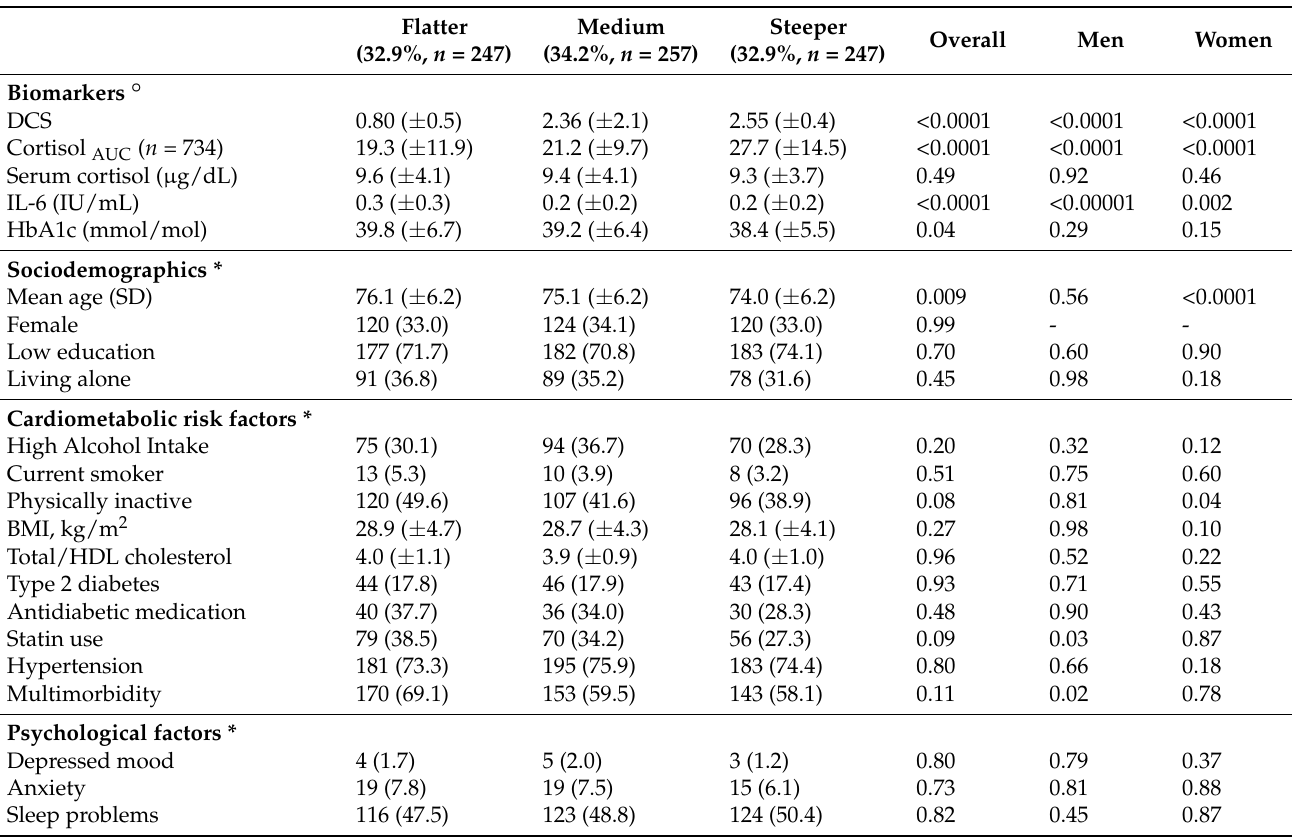
Table 2. Characteristics of the KORA-Age study population stratified by diurnal cortisol slope (DCS) tertiles (flatter, medium or steeper) in means ( ± SD) or N (%) ( n =